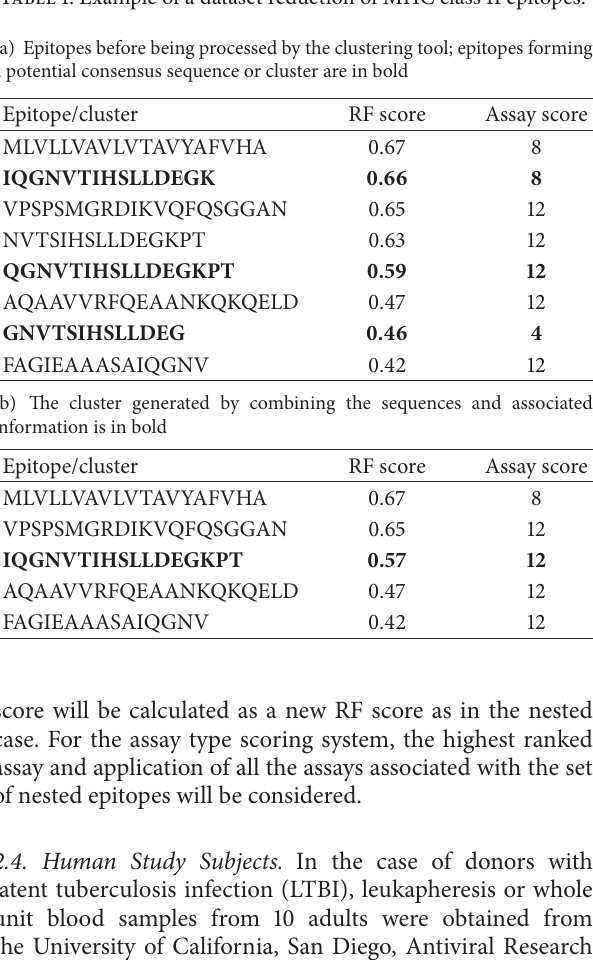
Table 1: Example of a dataset reduction of MHC class II